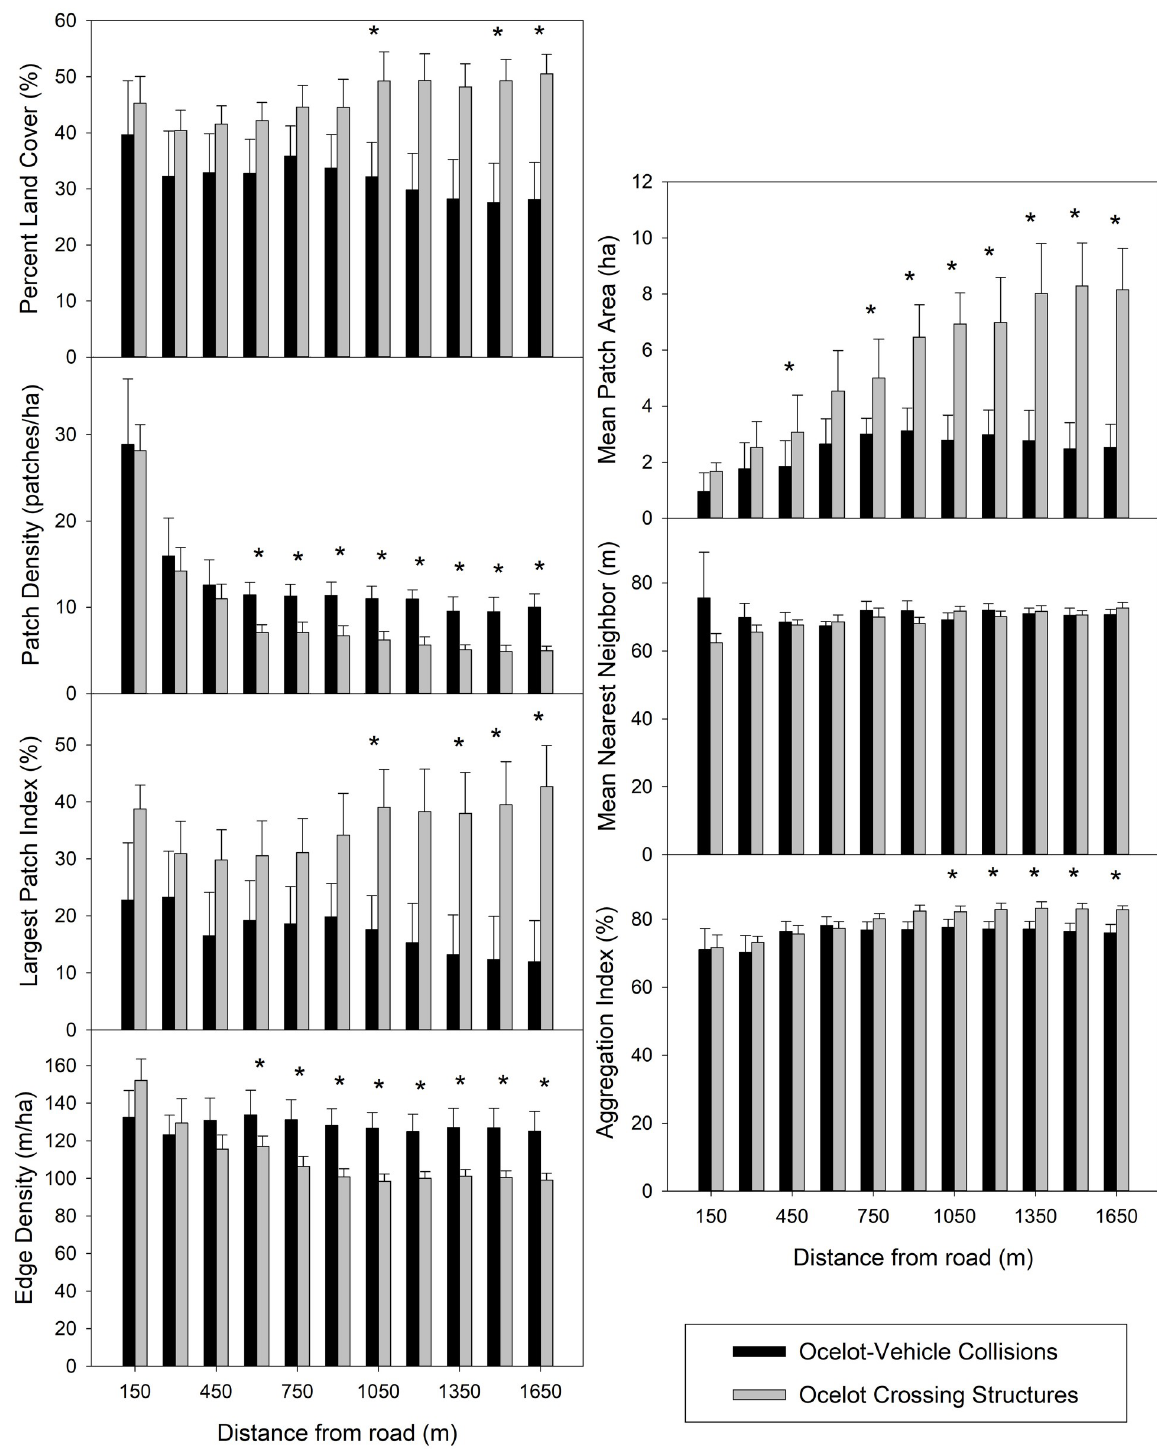
Fig 4. Median values of herbaceous vegetation structure between 26 ocelot-vehicle collision sites and 56 ocelot crossing structures. Asterisks on top of bars indicate significant differences based on Kolmogorov-Smirnov tests.